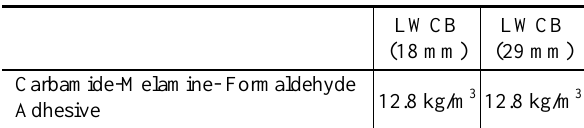
Table 2. The average content of chemical substances per 1 m 3 of board MDF